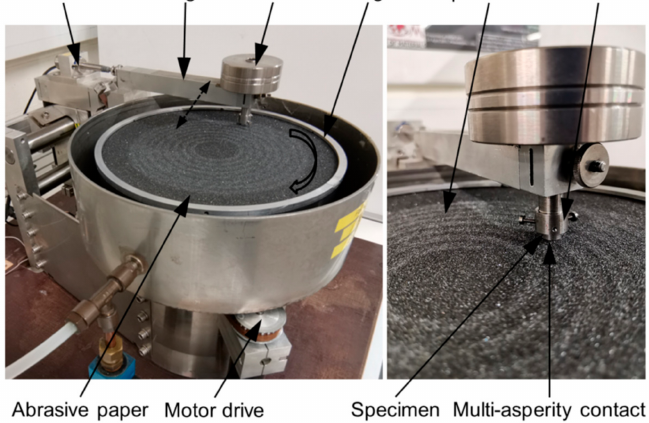
Figure 2. Abrasive pin-on-disc testing